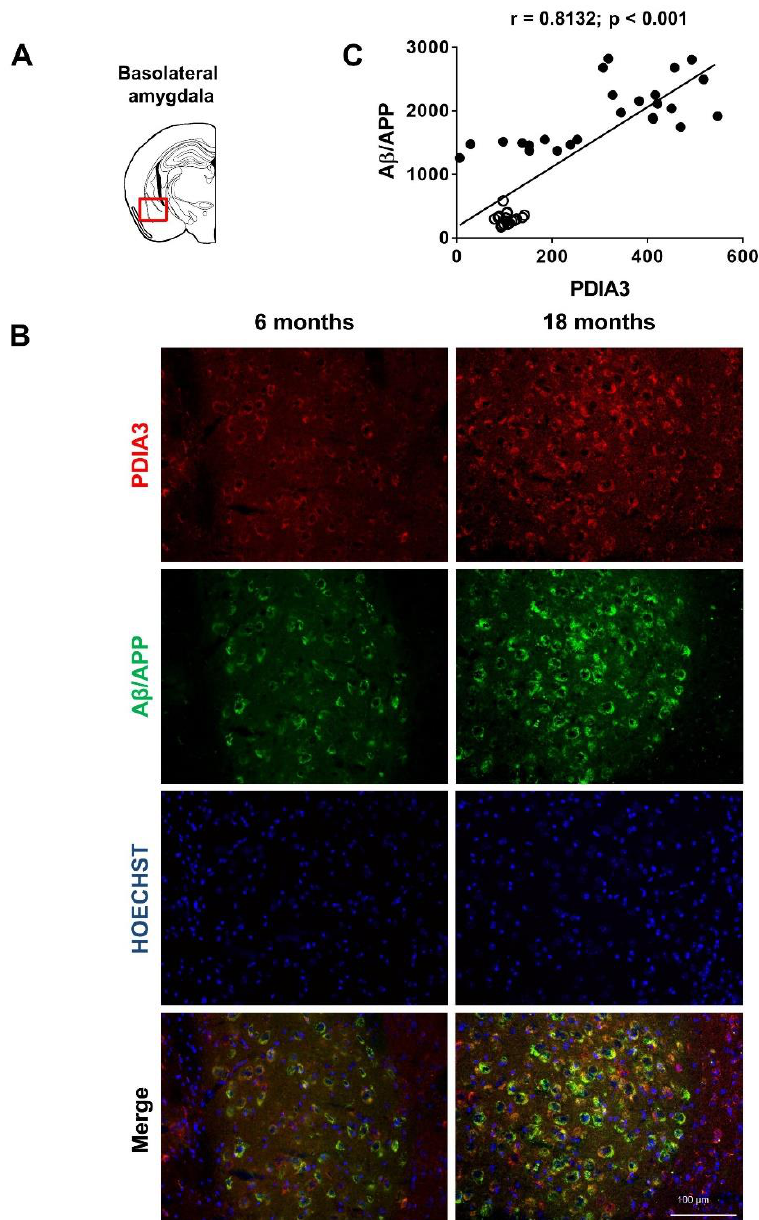
Figure 2. Aβ/APP -PDIA3 protein levels observed in the basolateral amygdala of 3×Tg-AD mice: ( A ) The brain diagram illustrates the site where the representative microphotographs of the basolateral amygdala were taken; ( B ) Representative microphotographs of Aβ/APP -PDIA3 double-fluorescent immunostaining (green and red, respectively) performed on brain slices of basolateral amygdala collected from 6- and 18-month-old 3×Tg-AD mice. Hoechst (blue) was used as fluorescent counterstain. Original magnification: 20×; scale bar was set at 100 µm; ( C ) Scatterplot of Aβ/APP vs. PDIA3 protein levels in the basolateral amygdala of 6- and 18-month-old 3×Tg- AD mice. Aβ/APP and PDIA3 levels refers to the results obtained by the semiquantitative analyses of the fluorescence signals as optical densities within the same cell and under the same exposure conditions. Open circles: 6-month-old 3×Tg-AD mice; closed circles: 18-month-old 3×Tg-AD mice. Data are expressed as mean optical densities ± SEM. Statistical significance threshold was set at p < 0.05.